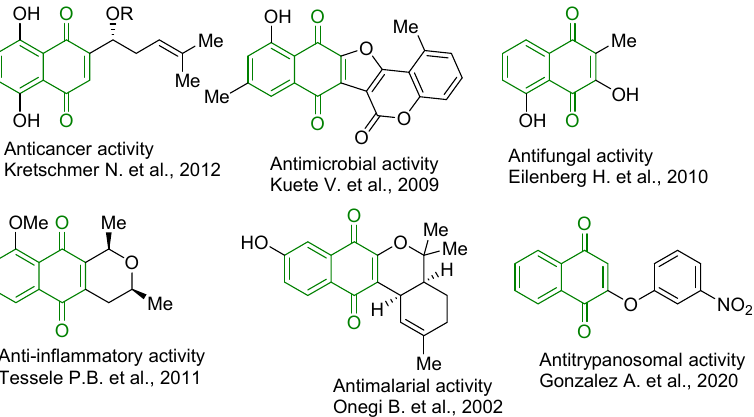
Figure 1. Structures of biologically active 1,4-naphthoquinone derivatives [12–15,17,19].